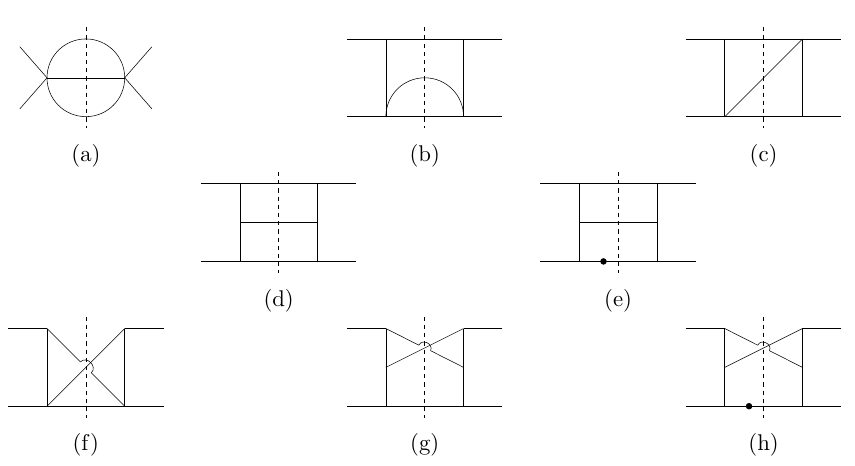
Figure 4 . The eight MIs needed to solve the two-loop integral. (a)–(e) are the planar MIs, while (a)–(c) and (f)–(h) are the non planar one. A dot on the propagator line means that it is squared in the